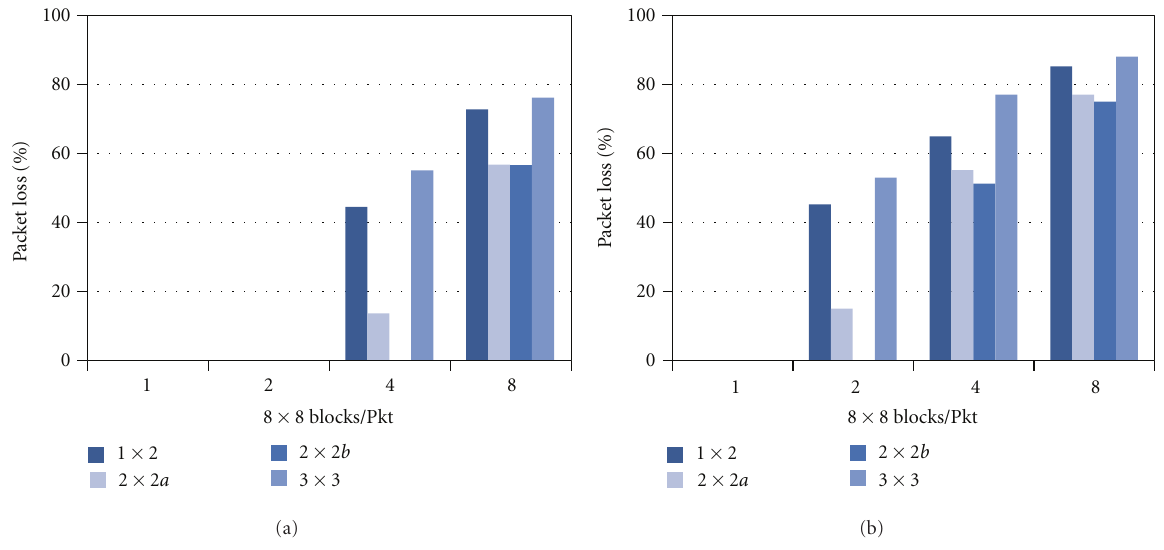
Figure 15: MPEG decoder: 500Pkt/s (a) and 1000 Pkt/s